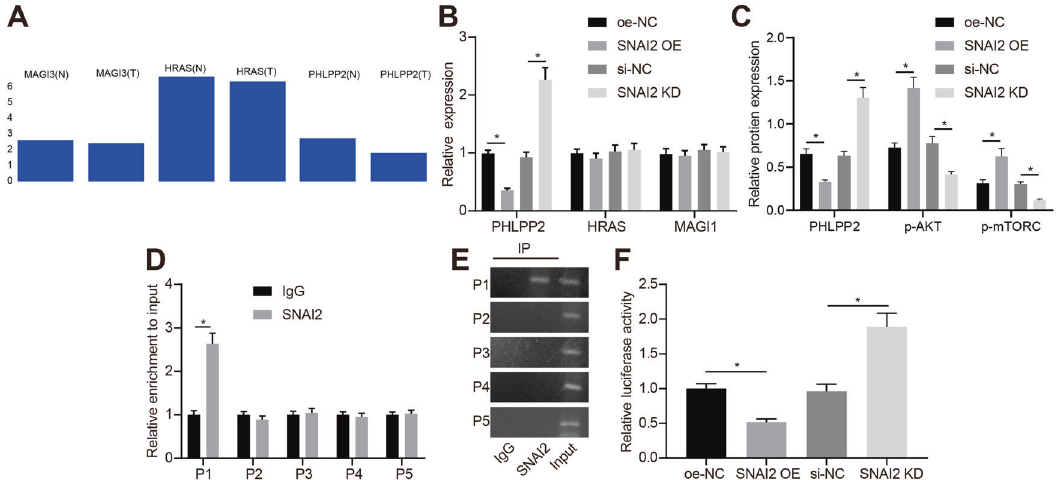
Fig. 4 SNAI2 activates the Akt pathway by inhibiting PHLPP2. A The expression of MAGI3, HRAS, and PHLPP2 in TCGA, the x -axis indicates the sample type and gene name, and the y -axis indicates the expression value (N indicates normal samples, T indicates tumor samples). B The expression of PHLPP2, MAGI1, and HRAS in the presence of oe-SNAI2 or SNAI2-KD as measured by RT-qPCR. C The expression of PHLPP2, p-Akt level, p-mTORC level and mTORC protein expression in the presence of oe-SNAI2 or SNAI2-KD in GSCs as measured by Western blot assay. D The binding site between SNAI2 and PHLPP2 promoter as detected by ChIP. E The binding site between SNAI2 and PHLPP2 promoter as detected by DNA agarose gel electrophoresis. F The binding ef fi ciency between SNAI2 and PHLPP2 promoter as examined by luciferase reporter gene assay. * p < 0.05 vs. GSCs treated with oe-NC or si-NC. Each cell experiment was repeated three times